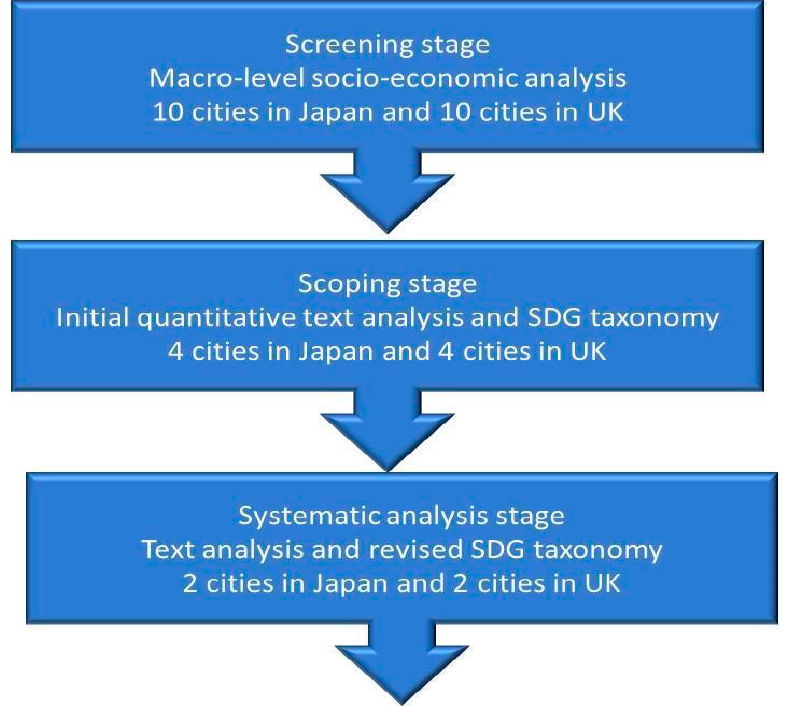
Figure 1. Research